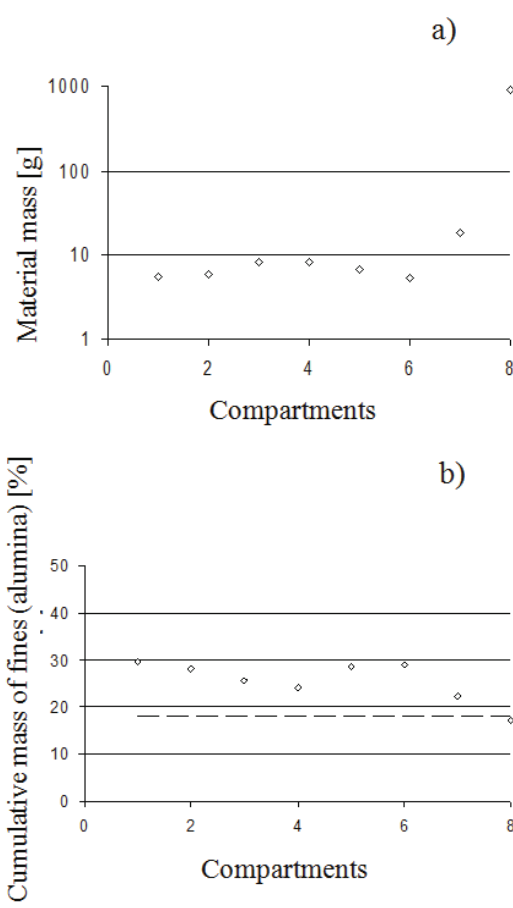
Fig. 9 Predicted segregation index (straight line) com- pared to experimental data from sand-water ex- periments (feeding rate 0.2 kg/min and water extraction rate 4 L/min with one repetition) and alumina-air experiments (feeding rate 0.8 kg/ min and air extraction rate 16 L/min with two